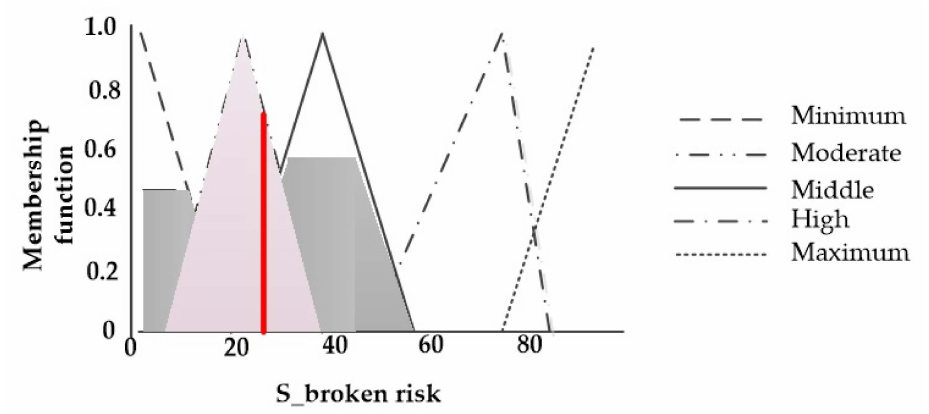
Figure 6. Graphical interpretation of the probability that the risk factor “probability of breakdown” with the parameters “bad” will manifest itself.